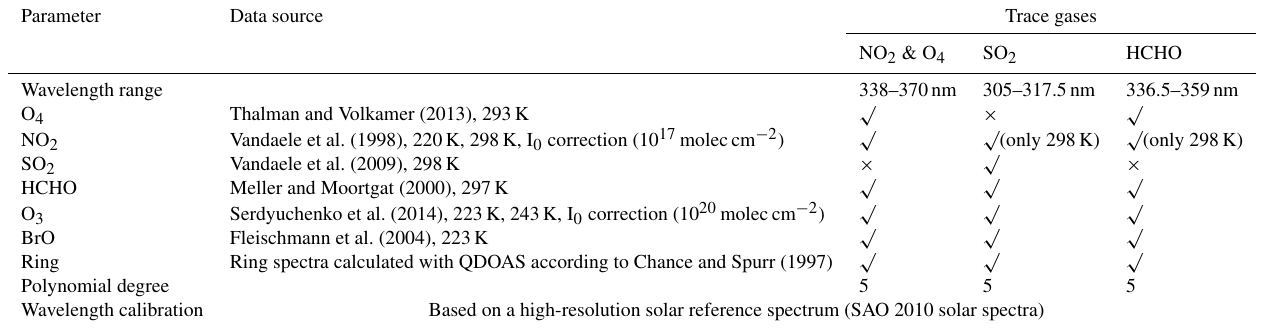
Table 1. DOAS spectral fitting of NO 2 , O 4 , SO 2 , and HCHO.